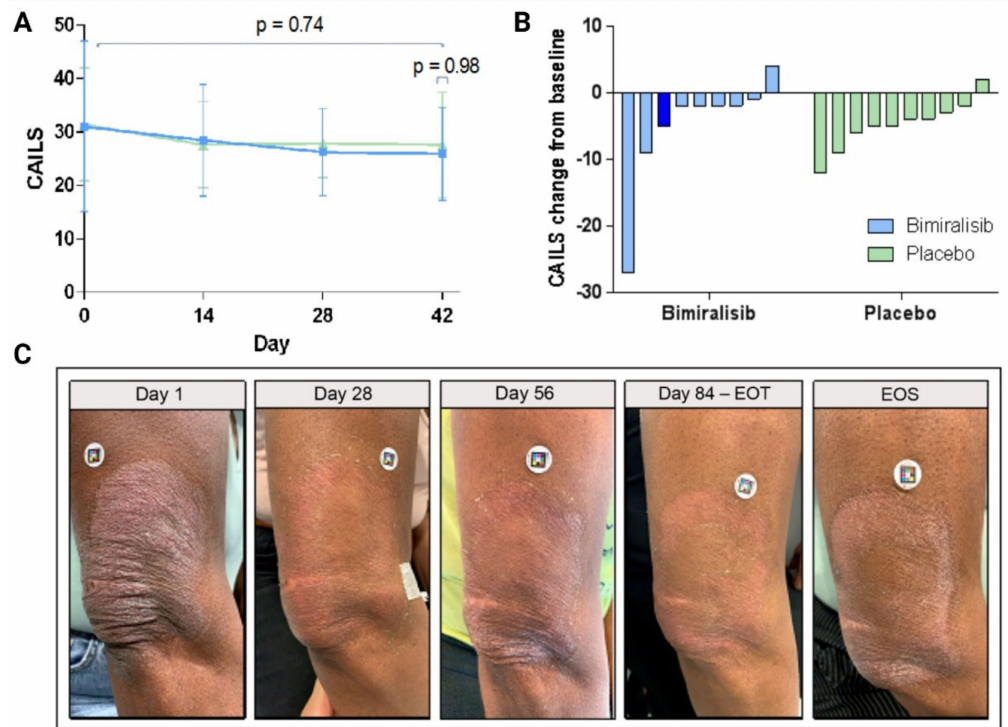
Figure 3. Clinical efficacy of bimiralisib 2.0% gel compared to placebo, by lesion improvement measured by CAILS in the per protocol population. ( A ) Absolute total CAILS score on days 14, 28 and 42 of daily topical gel application. No statistical significant difference in efficacy was detected between bimiralisib and placebo over time ( p = 0.74) or on day 42 ( p = 0.98). ( B ) Individual change of CAILS from baseline per patient. The dark blue bar indicates the patient shown in Figure 3C. ( C ) Clinical response of a single early-stage MF patient by SCARLETRED